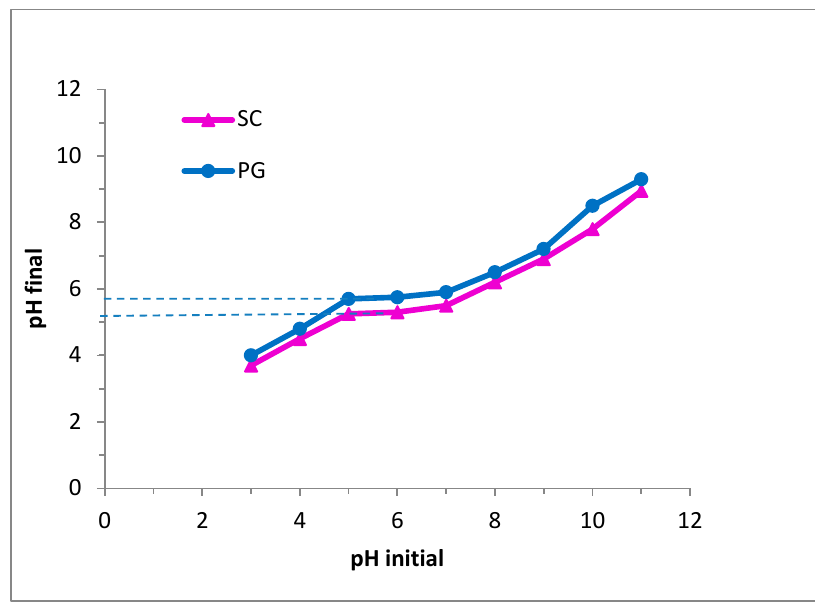
Figure 4. SC and PG zeta potential in aqueous suspension: influence of pH.